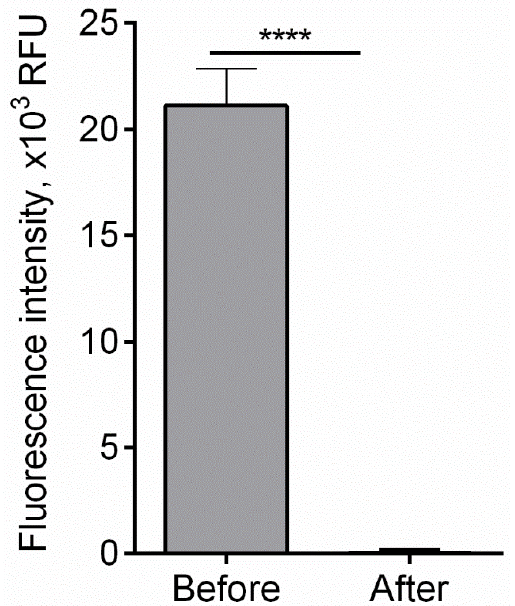
Figure A2. AF555-RNR retention by Exo-Spin collumns efficiency. The sample fluorescence data are presented as averages of 3 esperiments of 2 technical replicates; **** means statistically significant difference when p < 0.0001.